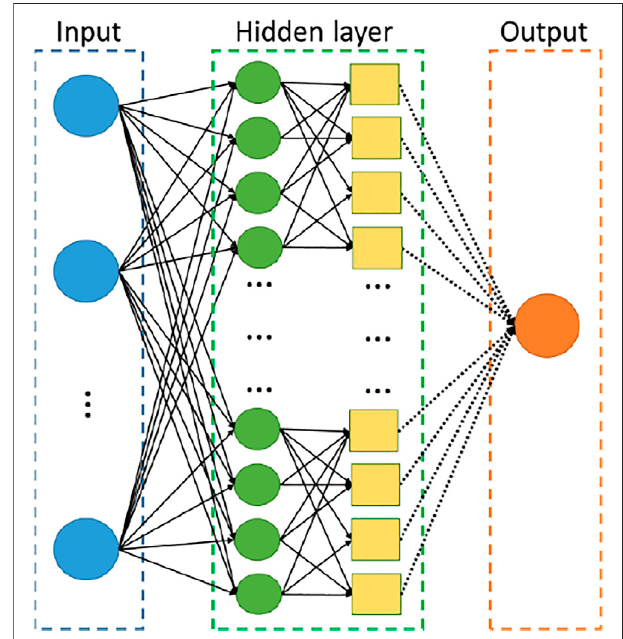
FIGURE 2 | NRF model structure with joint